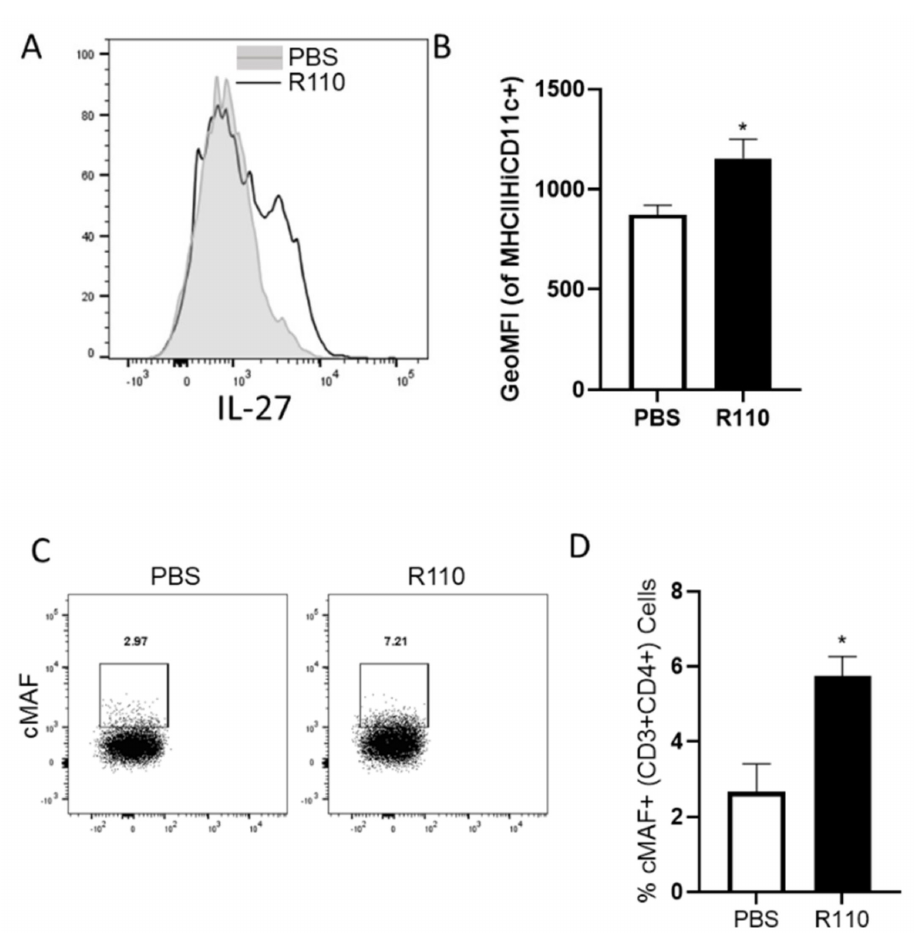
Figure 9. Oral administration of R110 increased IL-27 in colonic dendritic cells and c-MAF in T cells. Rag1 − / − mice were introduced with the 5 × 10 5 naive CD4 T cells to induce colitis. Mice were gavaged with R110 every week for a month. Colonic dendritic cells (CD45 + CD11c + MHC Hi ) were analyzed for IL-27 production. ( A ) Histogram showing the expression of IL-27 in control-derived dendritic cells (filled graph) or R110-derived dendritic cells (open graph). ( B ) Geometric mean of the fluorescence for PE channel representing IL-27. ( C ) Colonic CD4 T cells stained for cMAF dot plots. ( D ) bar diagram showing the percentage of CD4 T cells expressing cMAF; n = 5 mice/group; * p <